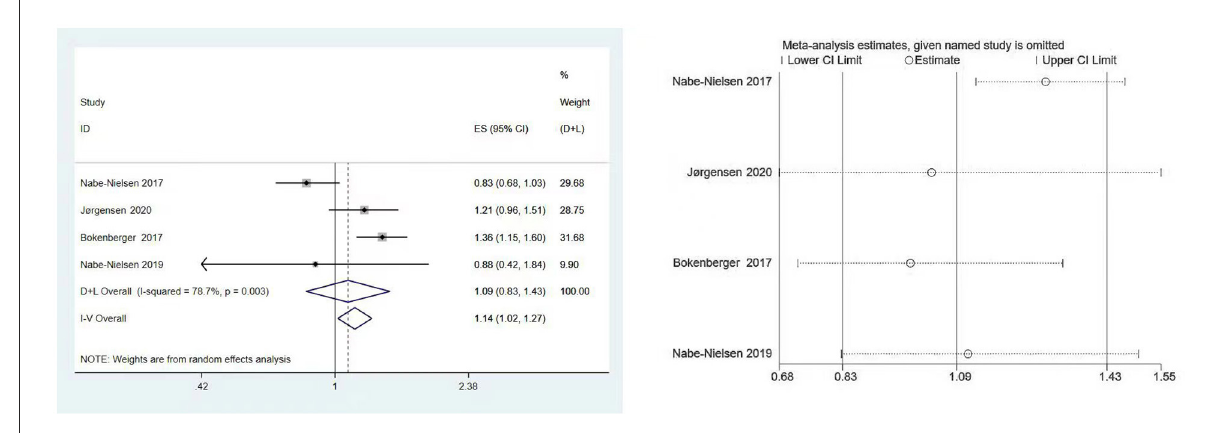
FIGURE2 Forest plot and sensitivity analysis of the relationship between shift work and dementia risk.